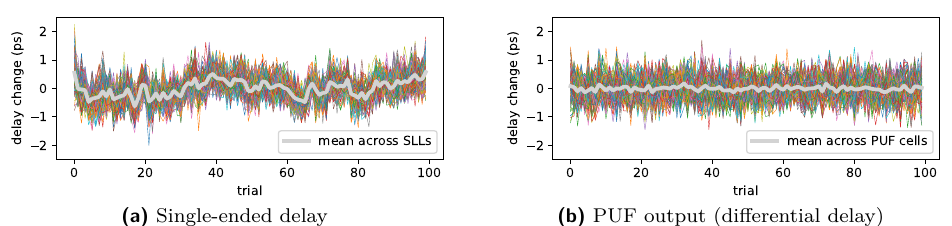
Figure 7: Delay drift across 100 trials on a single chip instance, using both single-ended delays and the PUF outputs. The differential nature of the PUF mitigates drift caused by factors that are common-mode to its two